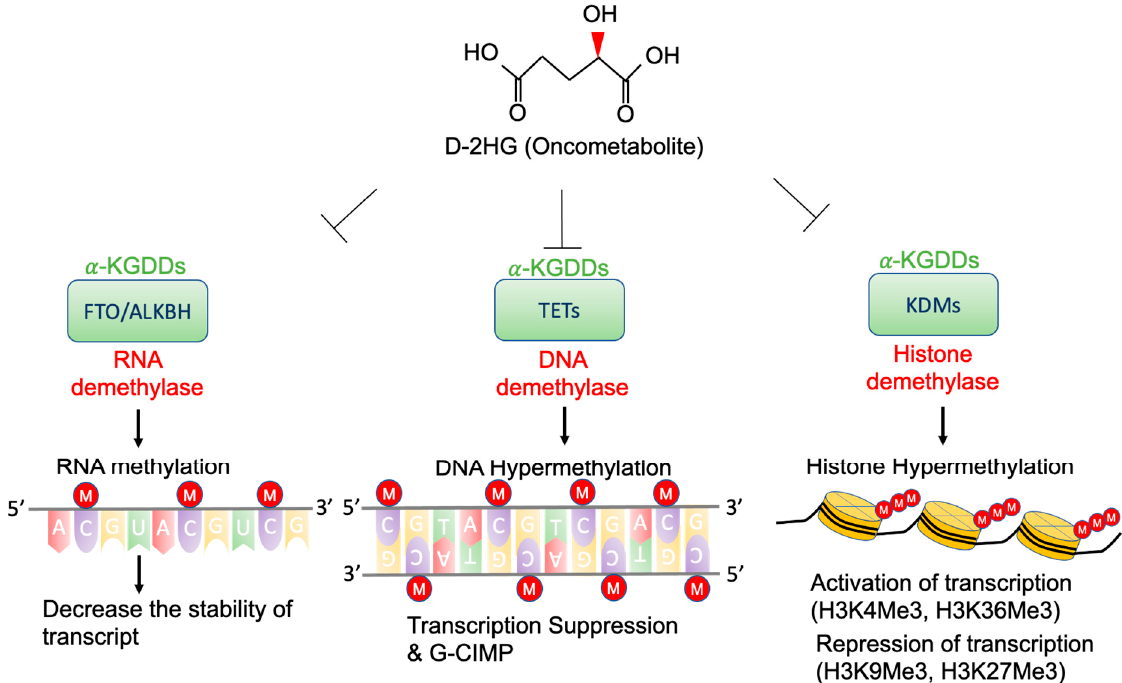
Figure 2. Epigenetic alterations of D-2-HG. D-2-HG alters the methylation status of DNA, RNA, and histone to regulate gene expression, and RNA stability via inhibition of various types of α -KDGG.